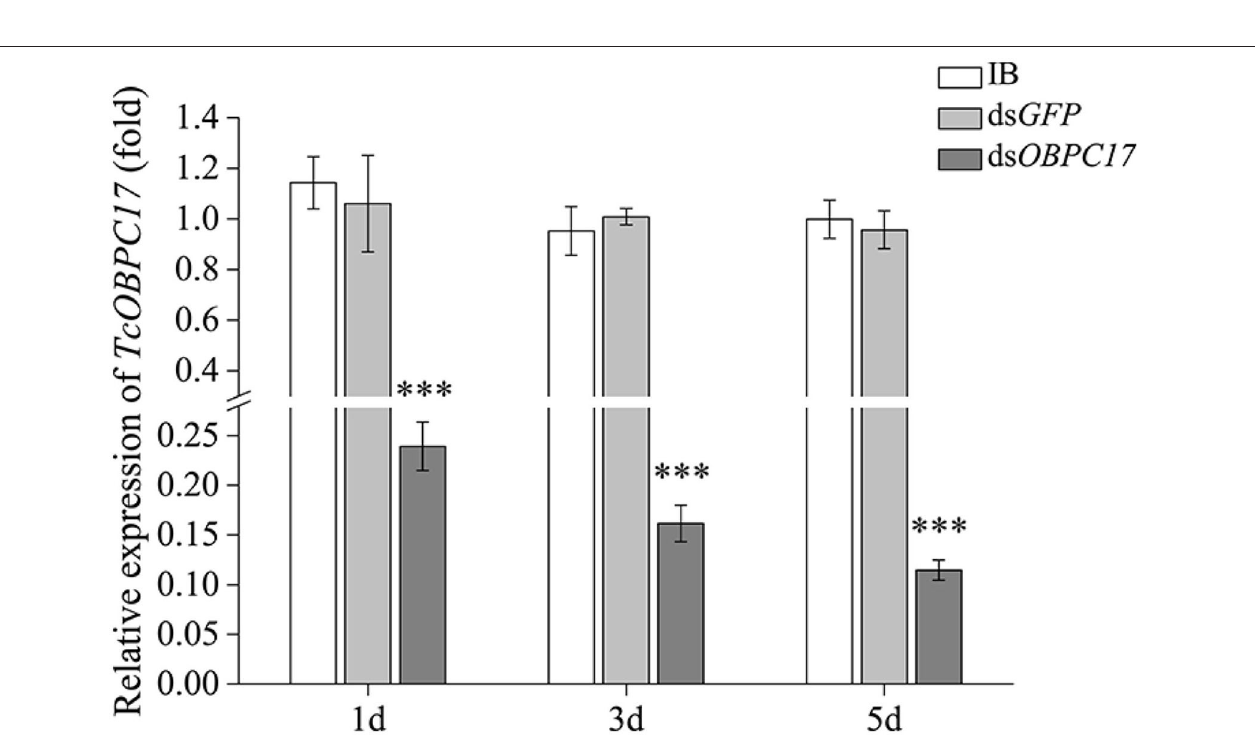
FIGURE 4 | Relative expression level of TcOBPC17 mRNA in T. castaneum 1, 3, and 5 days upon dsOBPC17 injection. The larvae injected with the equal volume of water (IB) or dsGFP served as the controls. The bars represent standard errors of the means ( n = 3). Fisher’s LSD test was employed to analyze the significant differences between the means (*** P <